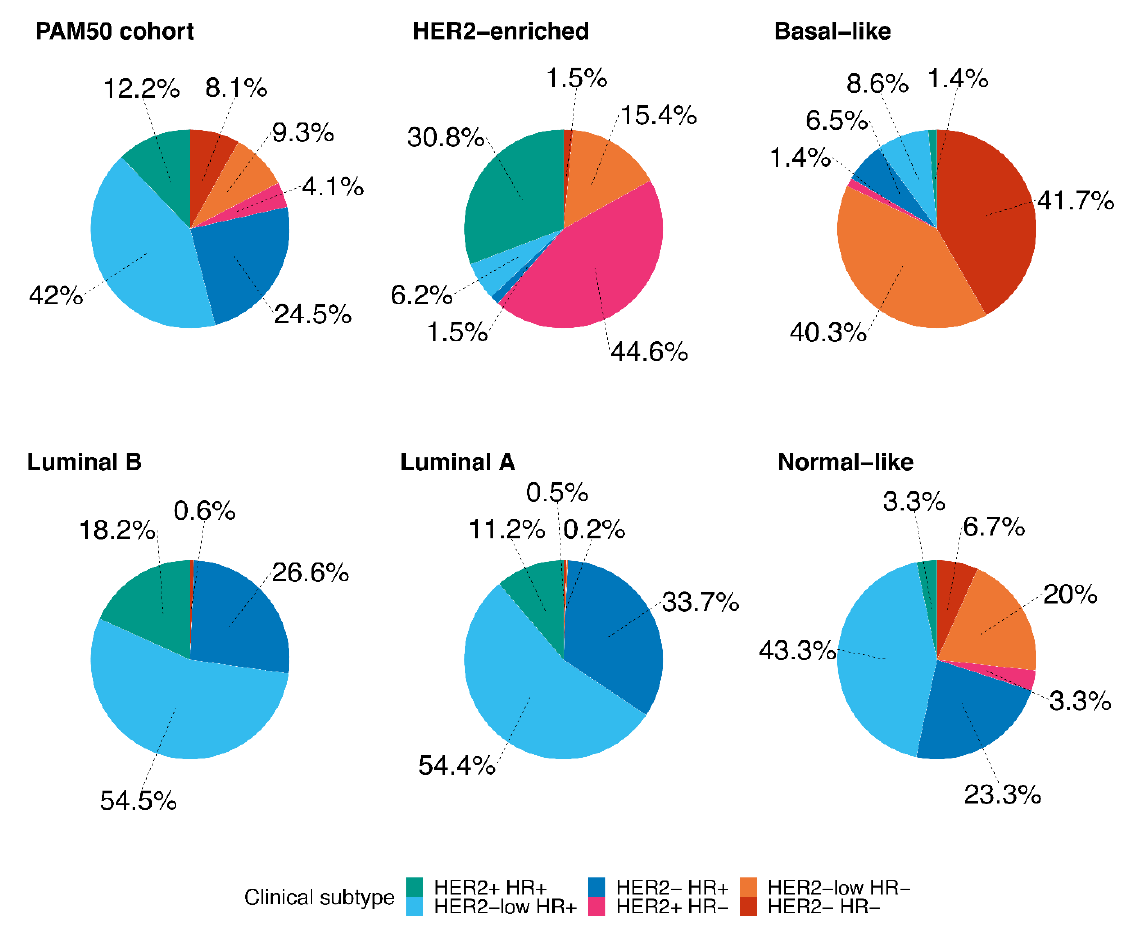
Figure 2. The distribution of breast cancer subtypes (HER2+/HR+, HER2-low/HR+, HER2−/HR+, HER2+/HR−, HER2- low/HR−, HER2−/HR−) according to PAM50 intrinsic subtypes ( n = 789). Abbreviations: HR: hormone receptor.